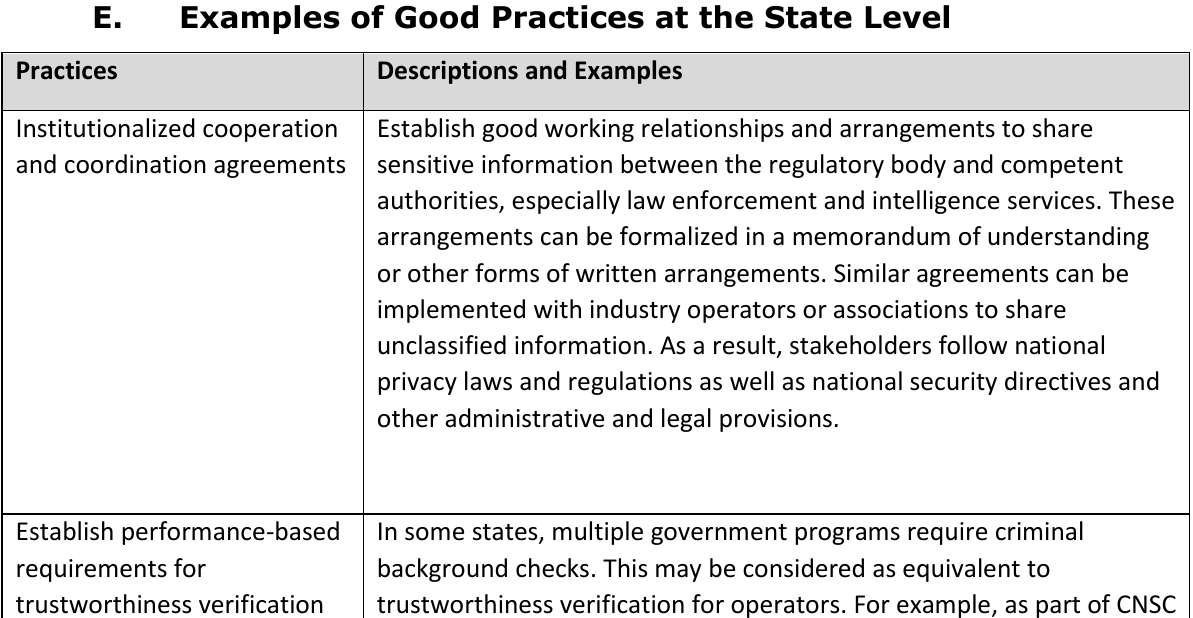
Figure 3: Table of Direct